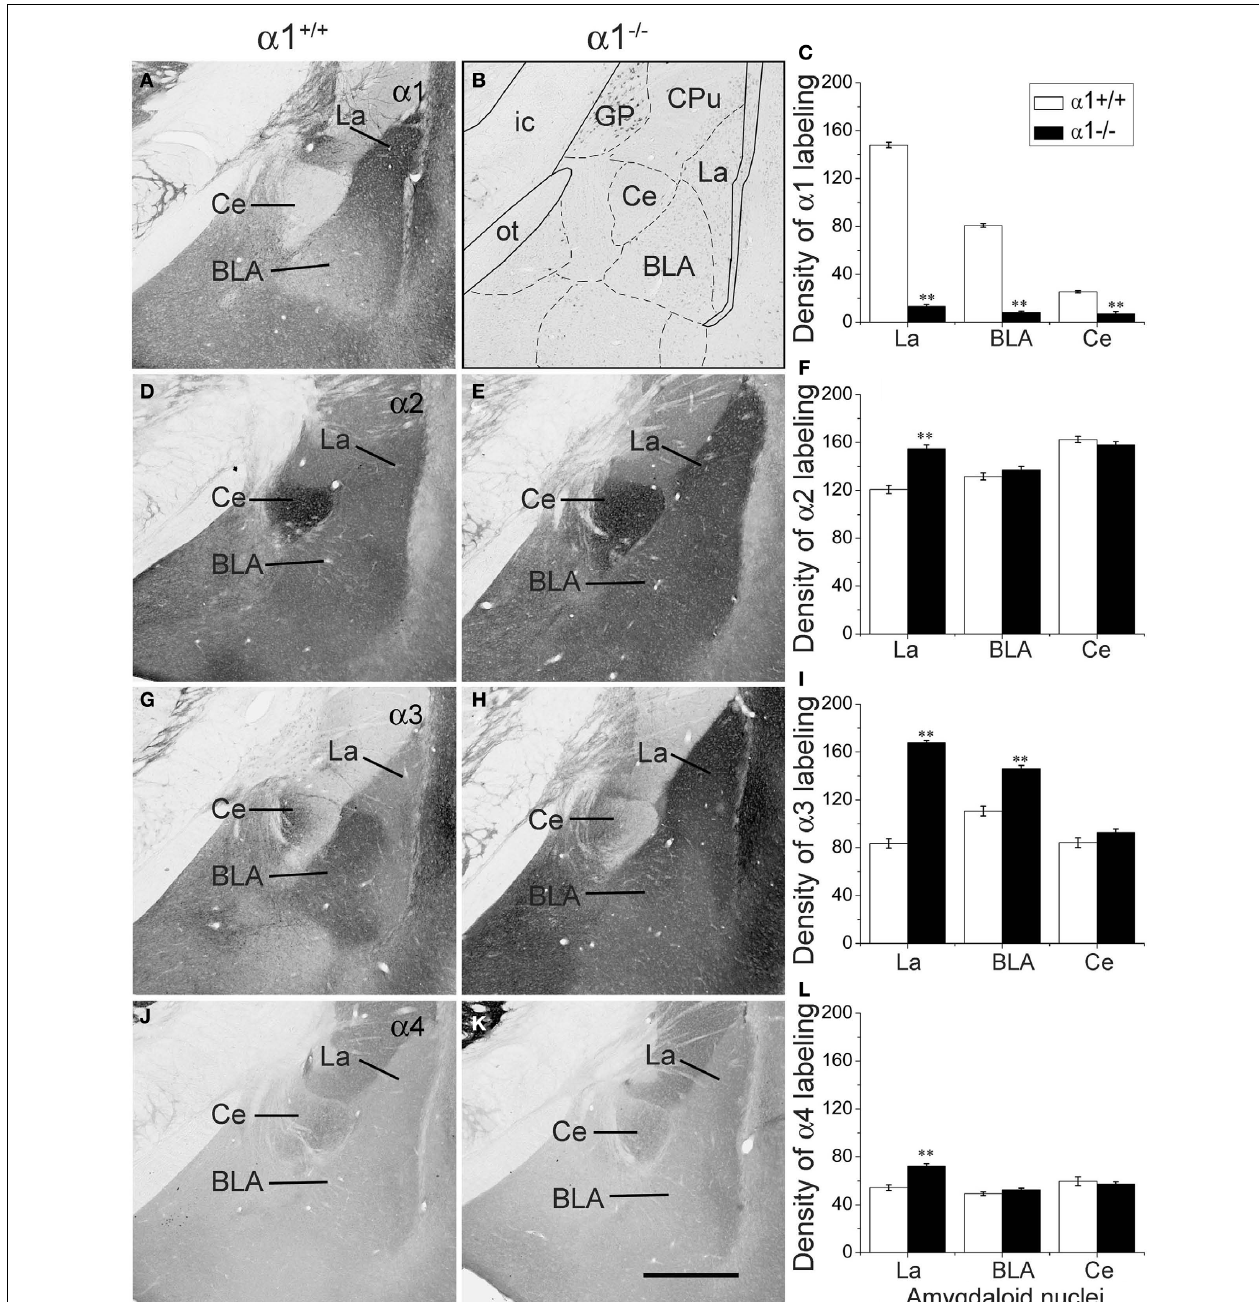
FIGURE 1 | Comparison of labeling for the α 1 (A–C), α 2 (D–F), α 3 (G–I) and α 4 (J–L) subunits in three amygdaloid nuclei in coronal sections of control and α 1 − / − mice. (A) In a control mouse, α 1 labeling is high in the lateral amygdaloid nucleus (La) but relatively low in the basolateral nucleus (BLA). Virtually no labeling is evident in the central nucleus (Ce). (B) In a α 1 − / − mouse, no specifi c α 1 labeling is present in the amygdaloid complex although a few cell bodies are labeled in the globus pallidus. A superimposed schematic drawing identifi es the location of the amygdaloid nuclei and nearby structures, including the globus pallidus (GP), caudate putamen (CPu), optic tract (ot) and internal capsule (ic). (D) In a control mouse, moderate α 2 subunit labeling is present in the lateral and basolateral nuclei, and strong α 2 labeling is evident in the central nucleus. (E) In α 1 − / − mice, α 2 subunit labeling is increased in the lateral nucleus,